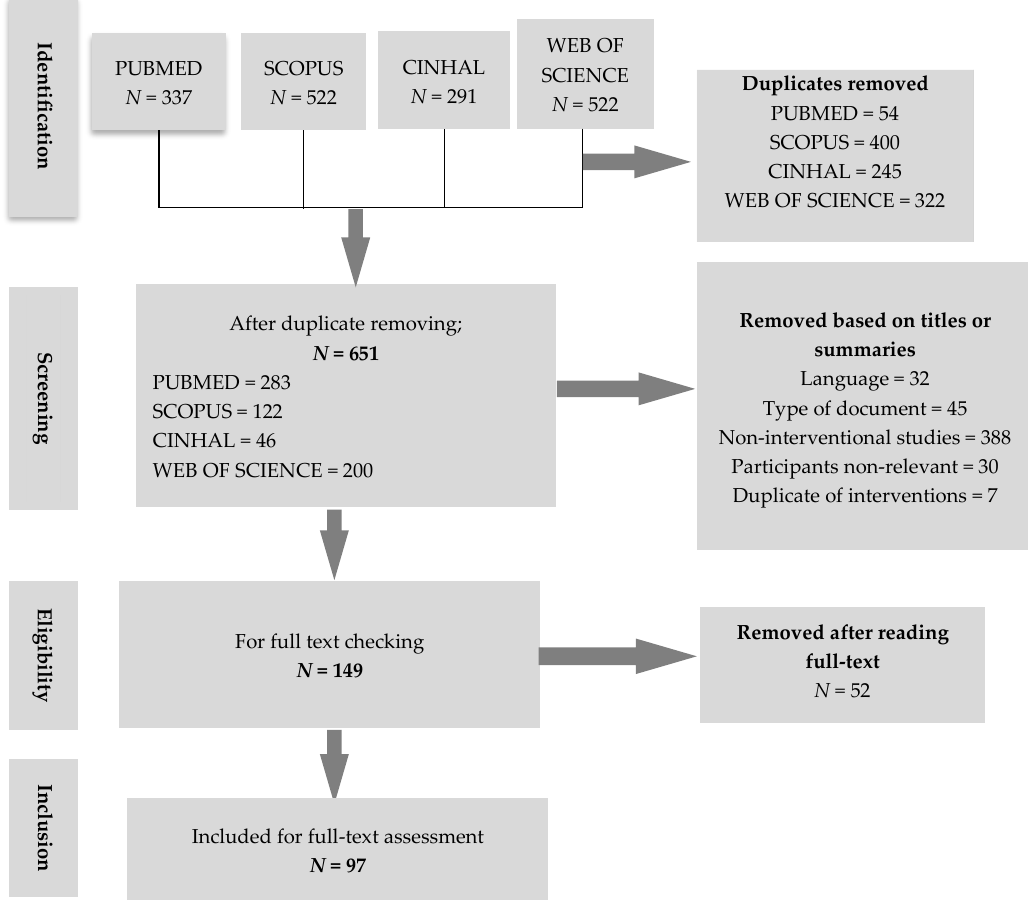
Figure 1. The inclusion process.